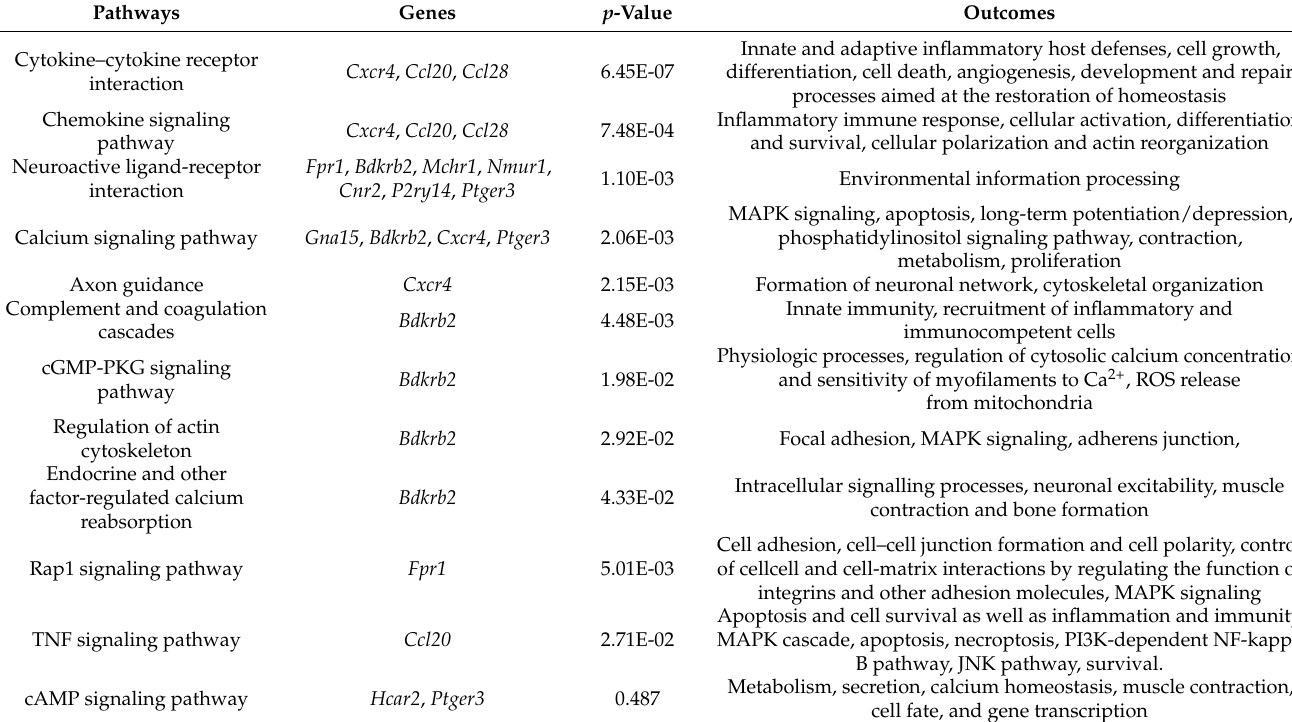
Table 2. Enriched pathways containing hub genes. The 12 hub genes are shown here in the context of enriched pathways they belong to. The table also provides the p -value of each pathway as well as the biological outcomes of each pathway. Red: upregulation. Blue: downregulation. Pathways Genes p